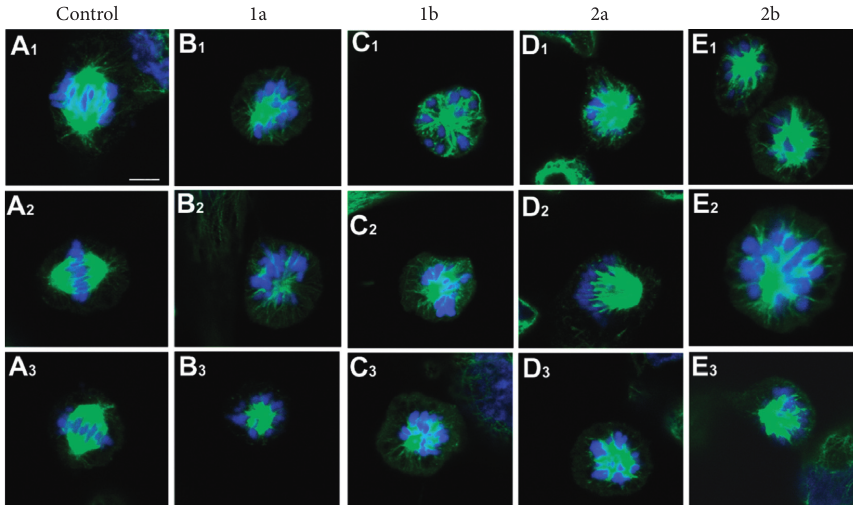
Figure 8: Spindle morphology of MDA-MB-231cells untreated (control, (a)) or treated for 24h with equitoxic concentrations (IC 1a ((b)), 1b ((c)), 2a ((d)), or 2b ((e)). Three representative images of mitotic MDA-MB-231 cells are shown, immunostained for tubulin (green) and DNA (blue); scale bar, 6 µ m For better resolution, see Figure S4.